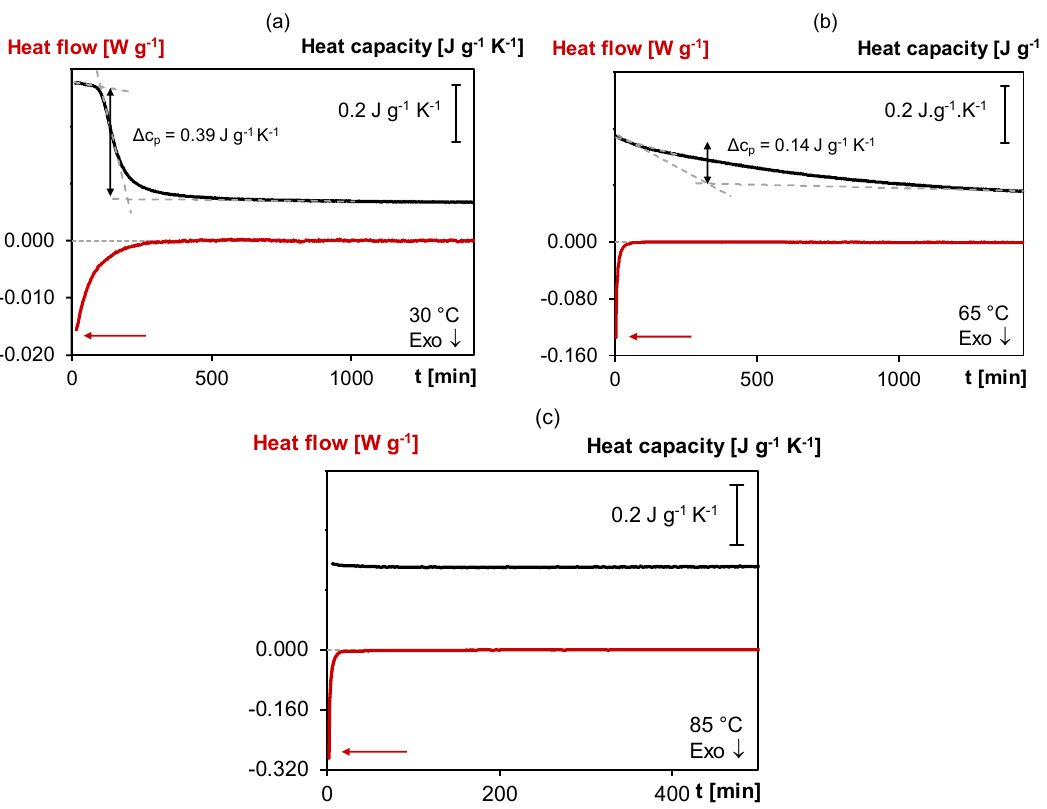
Figure 4. MTDSC thermogram of 3M-3F630 at isothermal cure temperatures of ( a ) 30 ◦ C, ( b ) 65 ◦ C, ( c ) 85 ◦ C. Black : (specific) heat capacity as a function of time; Red : (non-reversing) normalized heat flow as a function of time.